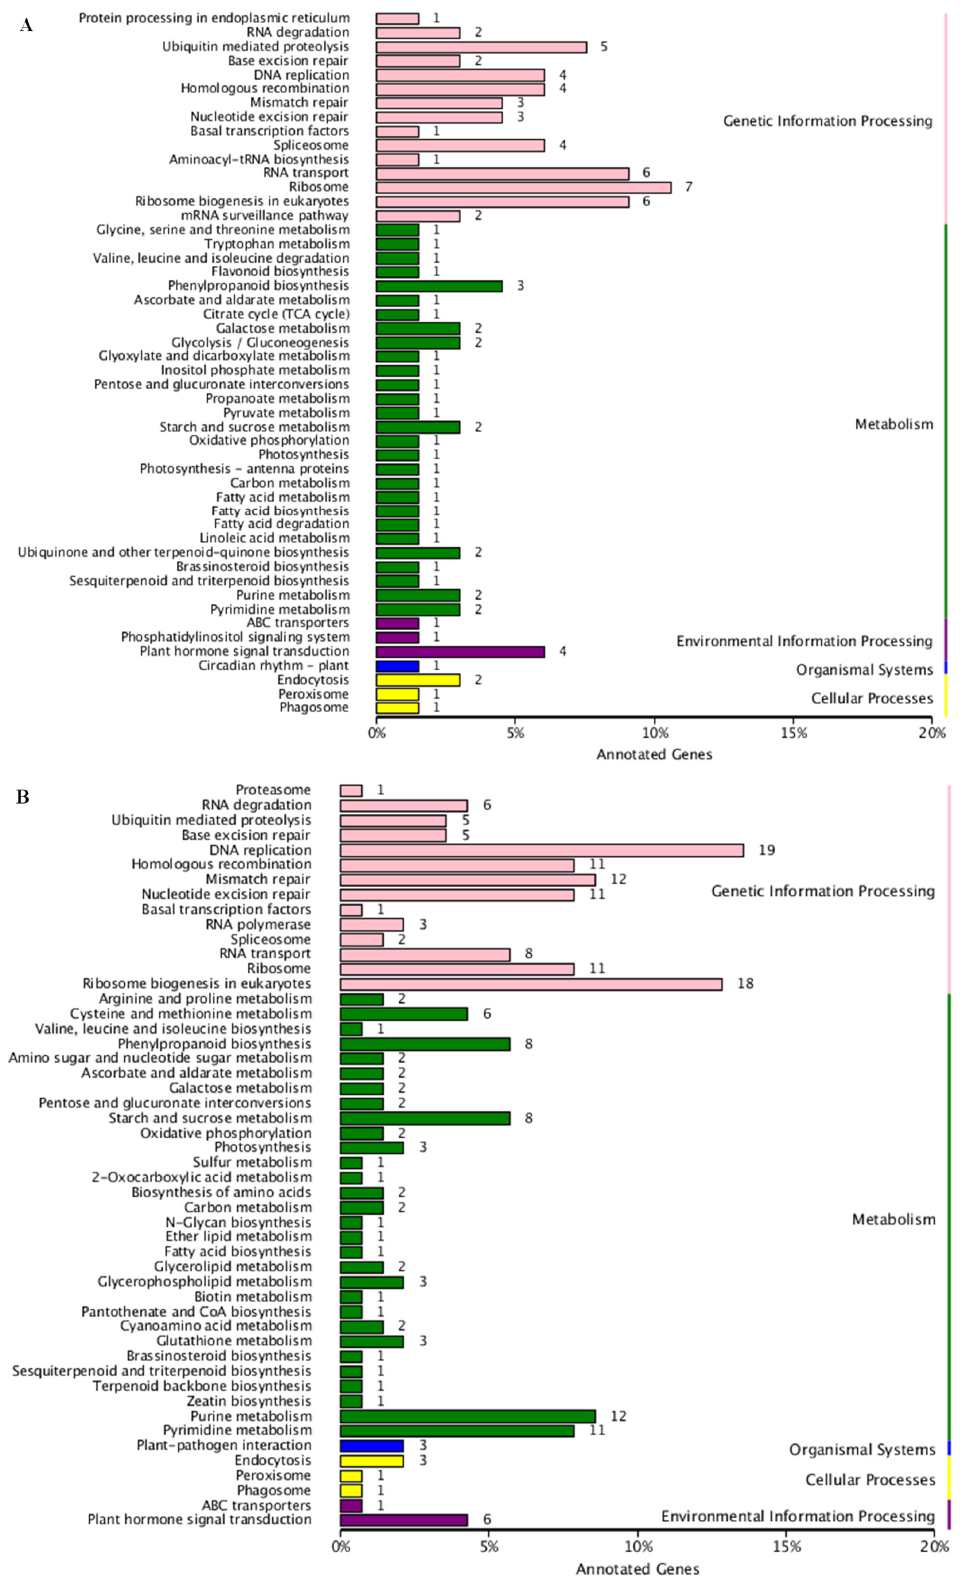
Figure 4. Pathway analysis of LK-tolerance-related DEGs based on the KEGG data after 48 h ( A ) and 15 d ( B ) of LK stress. The X-axis indicates the pathways; the Y-axis indicates the numbers of annotated